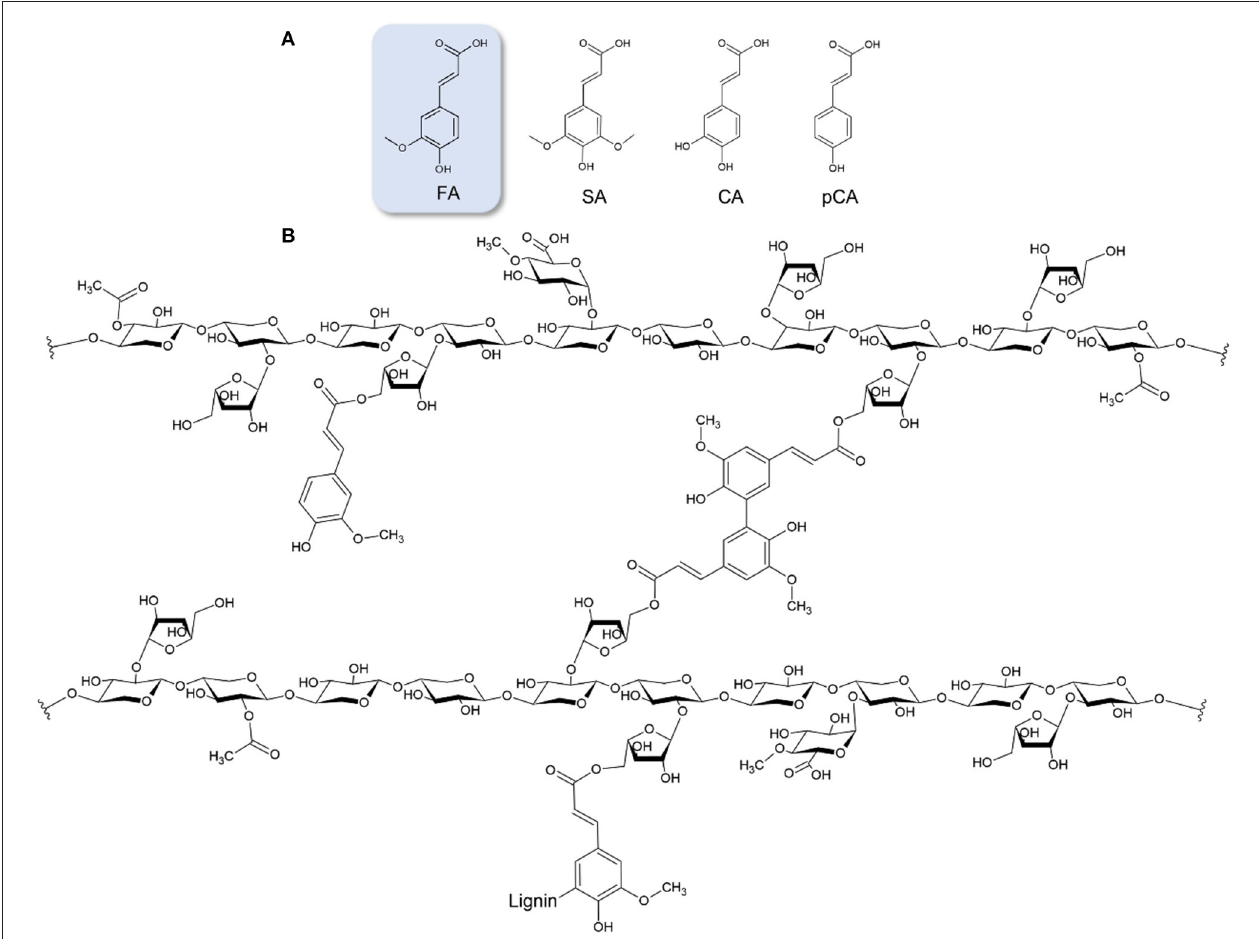
FIGURE 1 | (A) Hydroxycinnamic acids; FA, ferulic acid; SA, sinapic acid; CA, caffeic acid; pCA, p -Coumaric acid. (B) Example of feruloylated glucuronoarabinoxylan, where FA is esterified to the O -5 hydroxyl group of a-L-arabinofuranose. Cross-linkage between hemicellulose chains is an example of a 5,5 ′ FA dehydrodimer. FA linkage with lignin is also